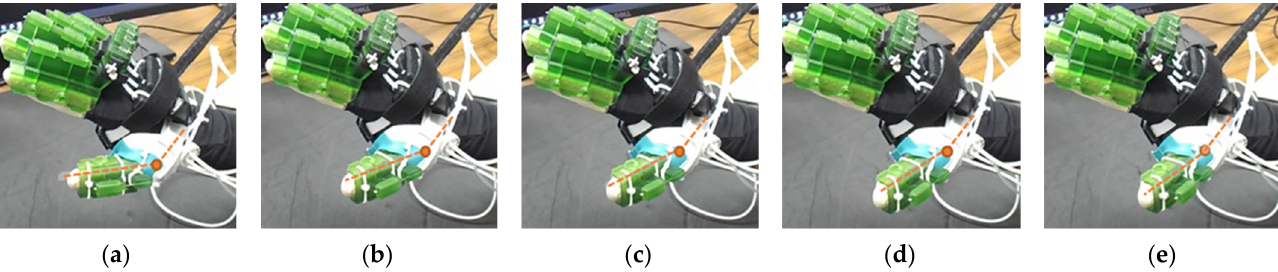
Figure 18. Fingers’ PIP flexion: ( a ) index, middle, ring, and small finger PIP joints are extended, PIP joint angle: 0°; ( b – d ) intermediate PIP joint positions; and ( e ) PIP joints are flexed, PIP joint angles: 80–82°.